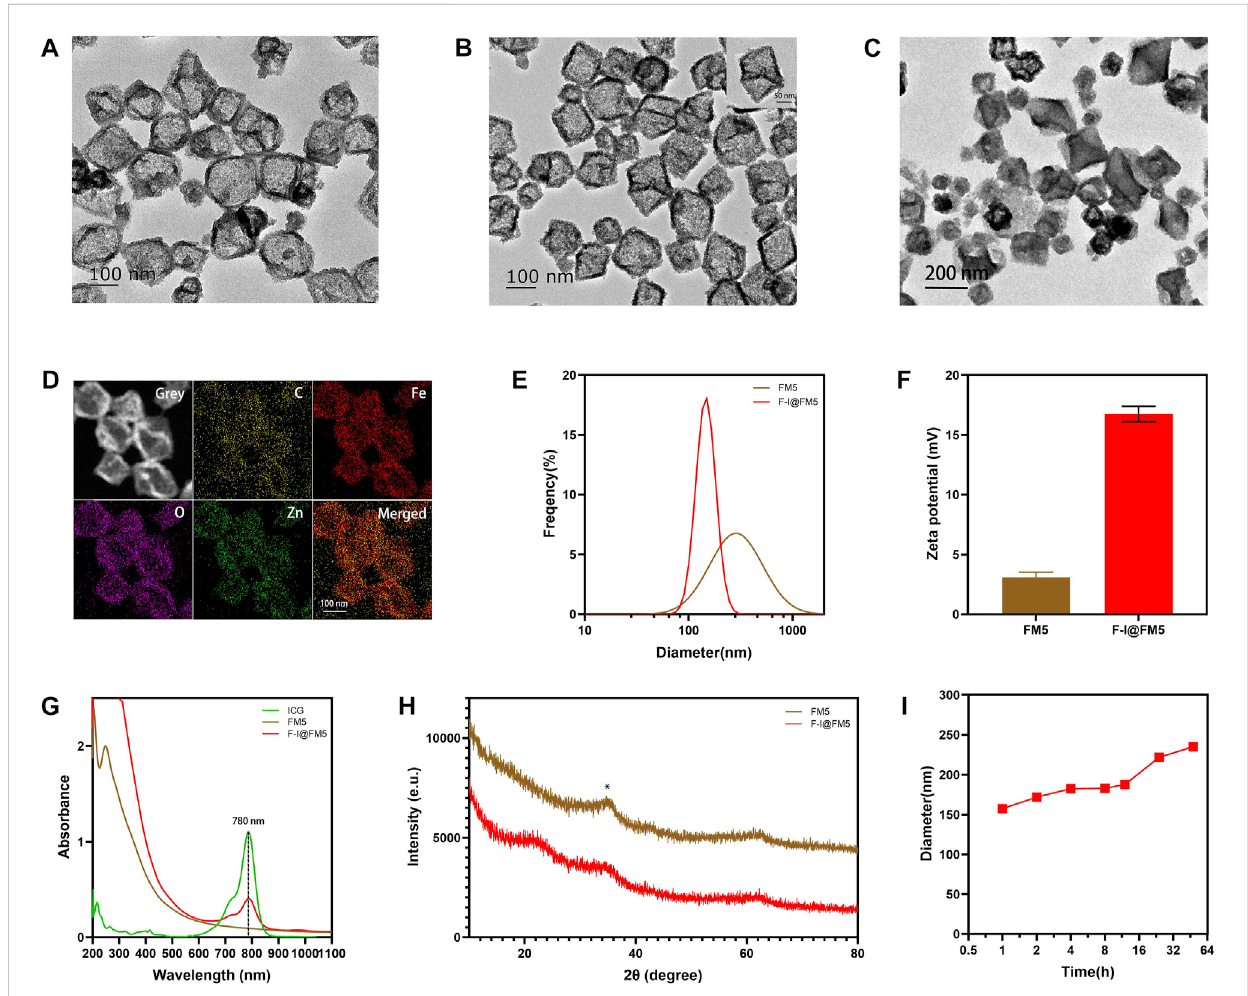
Preparation and characterization of F-I@FM5. (A) TEM images of I@FM5 (Scale bar equal to 100 nm). (B) TEM images of F-I@FM5 (scale bar 100 nm, scale bar in the inset 50 nm). (C) TEM images of F-I@FM5 treated with an acid solution (scale bar 200 nm). (D) EDS mapping of Fe, Zn, O and C, respectively. (E) Dynamic light scattering analysis of FM5 (478 nm) and F-I@FM5 (156.52 nm). (F) Zeta potentials of FM5 and F-I@FM5. (G) Absorption spectra of ICG, FM5, and F-I@FM5. Characterized peaks of ICG at 780 nm were observed in F-I@FM5, implying the successful construction of